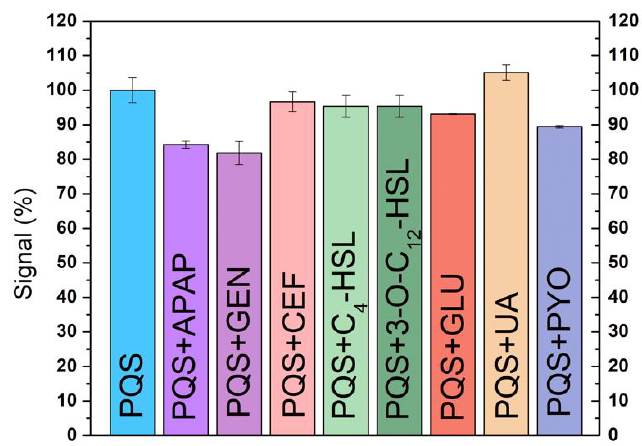
Figure 8. Selectivity of the SPE-CNTs for PQS.